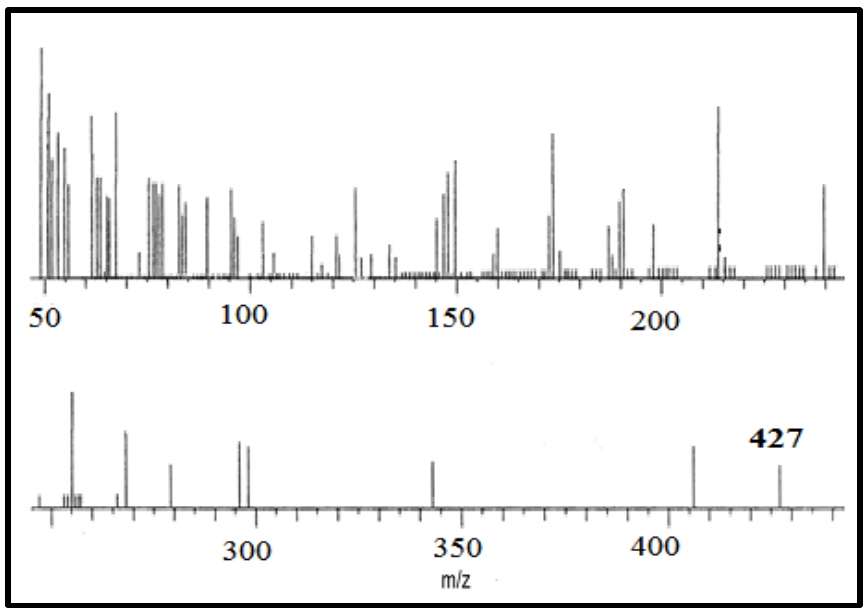
Figure 2. Mass spectrum of HAO.